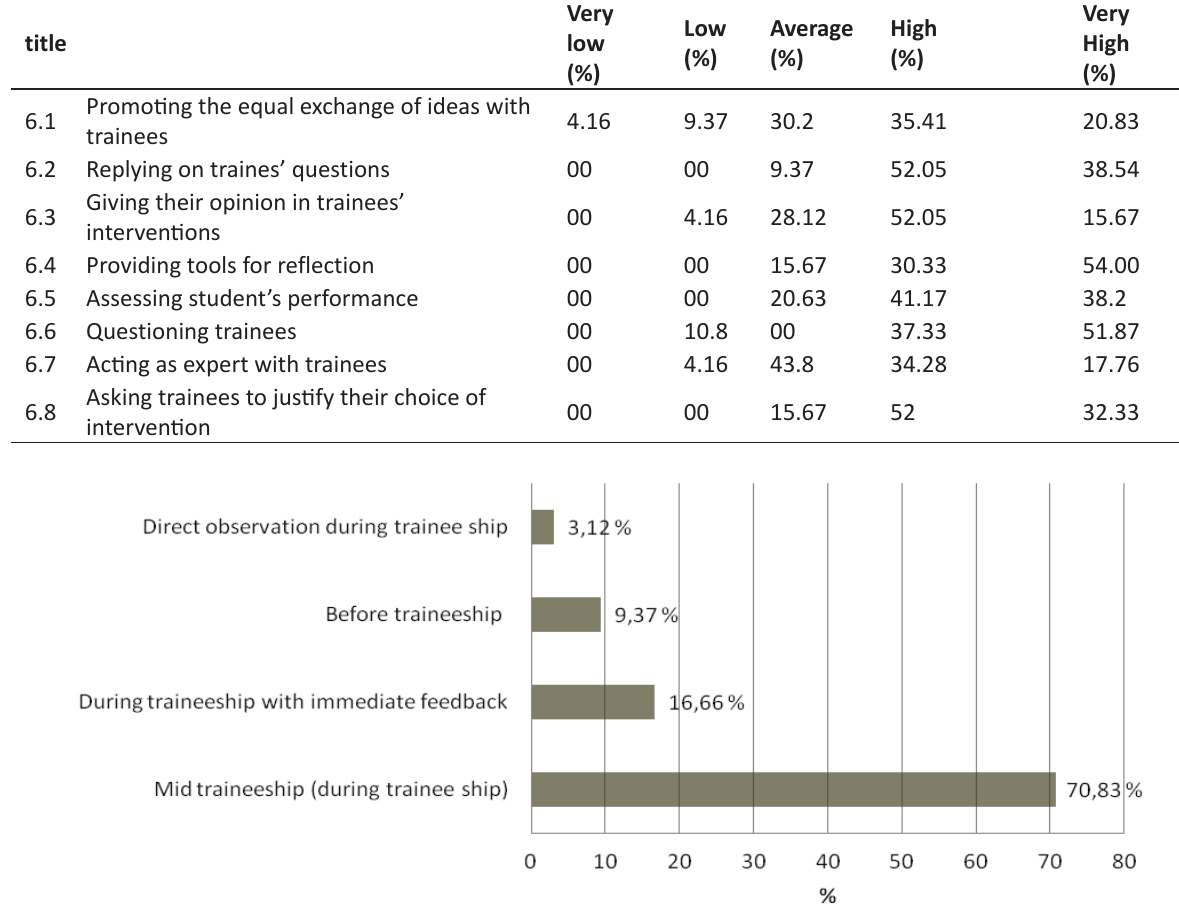
Figure 1 . Moment of formative assessment